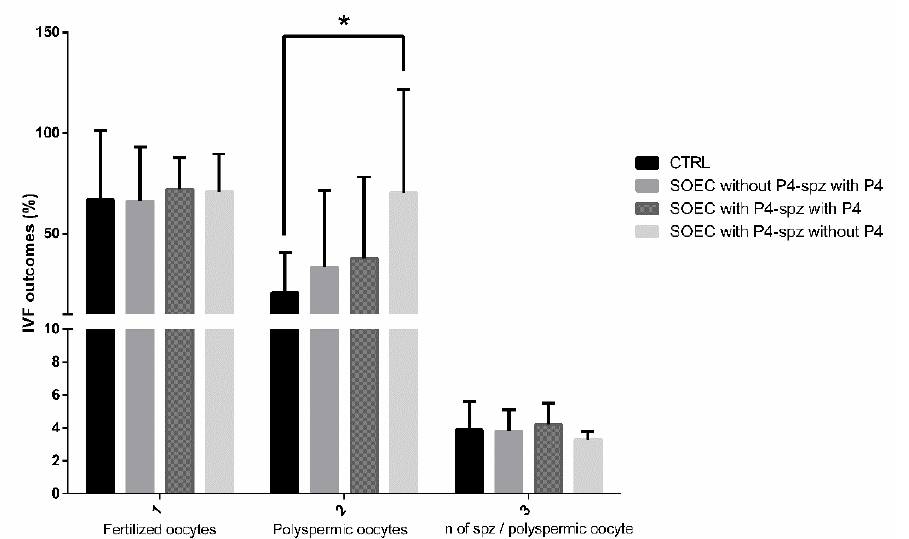
Figure 5. IVF outcomes: comparison between pre-treatment of SOECs with P4 and addition of P4 during sperm capacitation. The graph shows the effects of co-incubation of sperm during capacitation with P4 (100 ng/mL) and SOECs pre-treated with P4 (100 ng/mL) on IVF outcomes. By analyzing the graph, it arises that the best IVF outcomes are obtained when SOECs are pre-treated with P4 at 100 ng/mL and sperm capacitation is performed without the addition of P4. The data are presented as mean of four independent experiments. Data were analyzed using a Dunnett’s test. * p < 0.05 versus control.